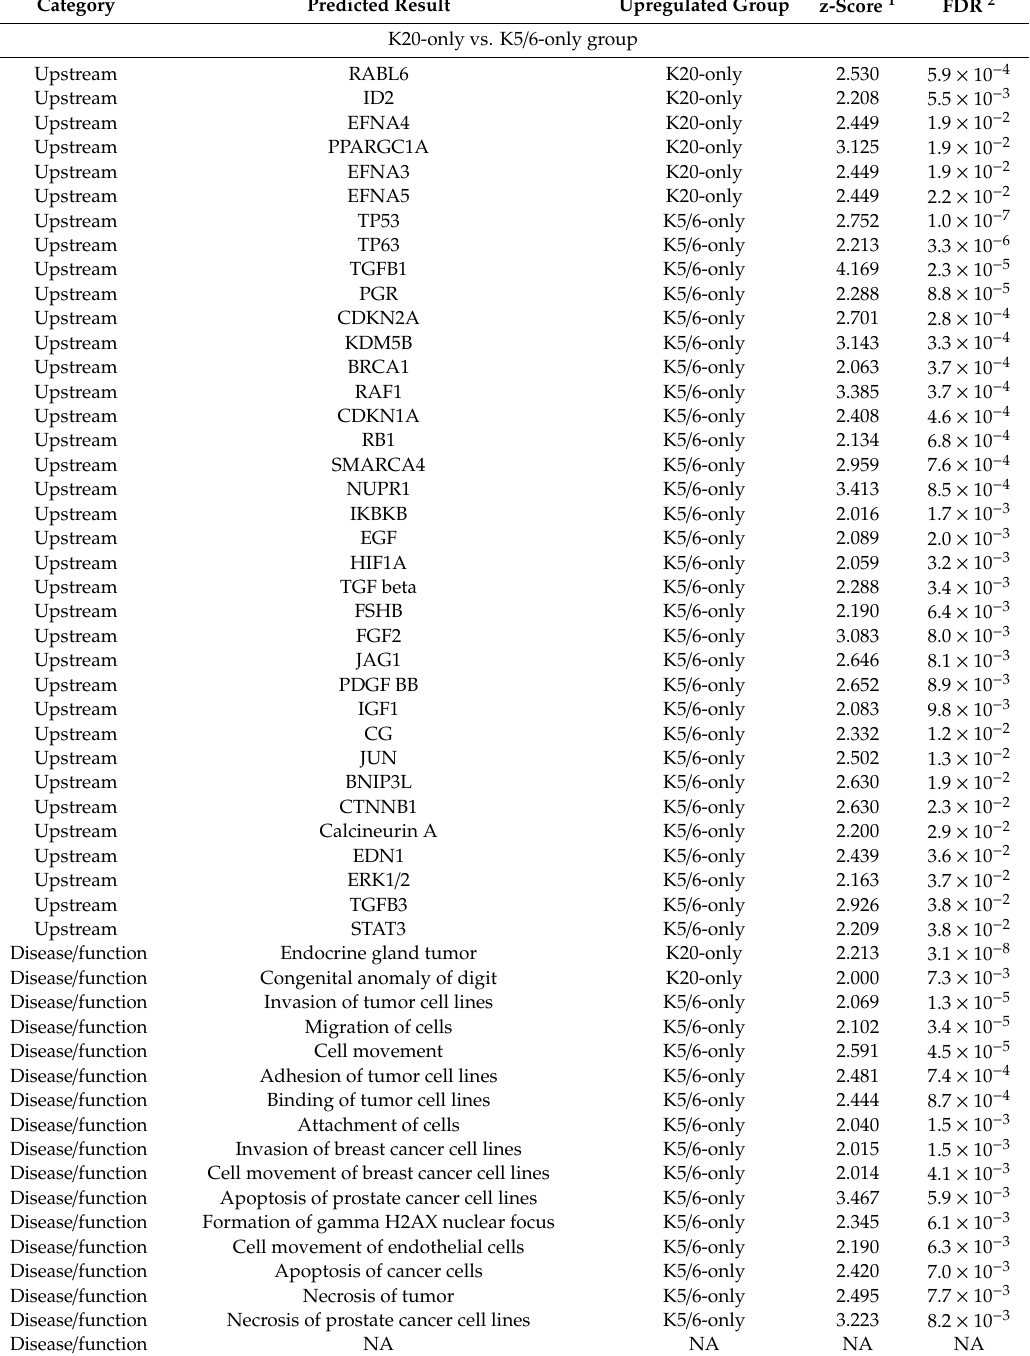
Table 1. Significant functional enrichment predicted by Ingenuity Pathway